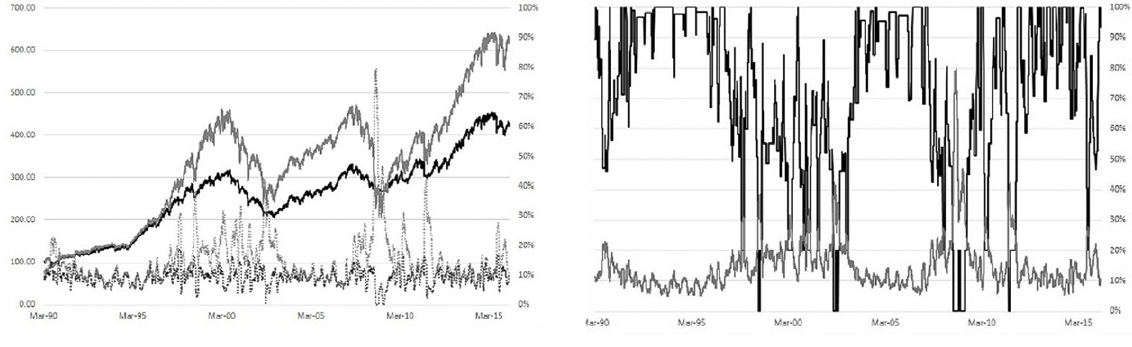
Figure 7. Comparative results for the DTVS STD portfolio and the S&P 500 Note: The left side presents the path of DTVS STD (solid black line) and of S&P 500 (solid gray line), and the DTVS STD rolling standard deviation (dotted black line) and the S&P rolling standard deviation (dotted gray line). The right side presents how the equity exposure of the DTVS STD (solid black line) changes with respect to the volatility of the S&P 500 (solid gray line).